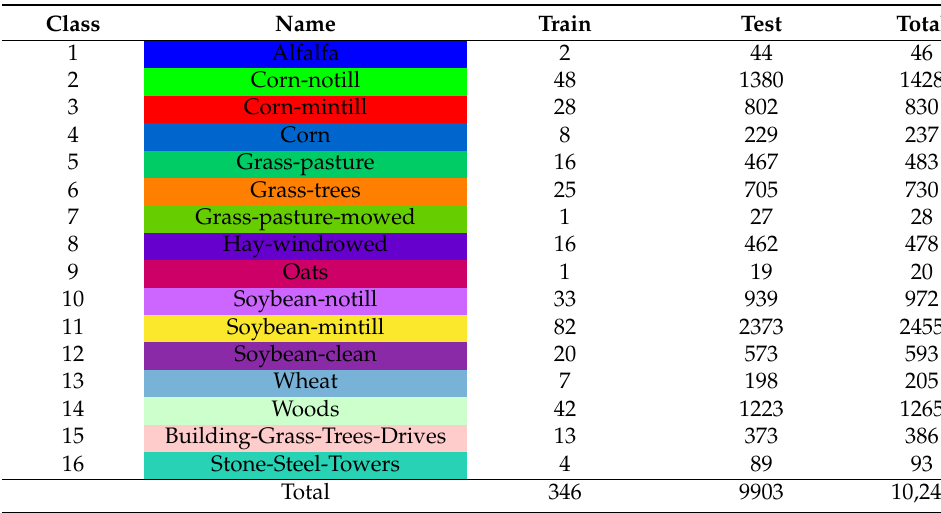
Table 1. Train-test distribution of samples for the Indian Pines dataset.